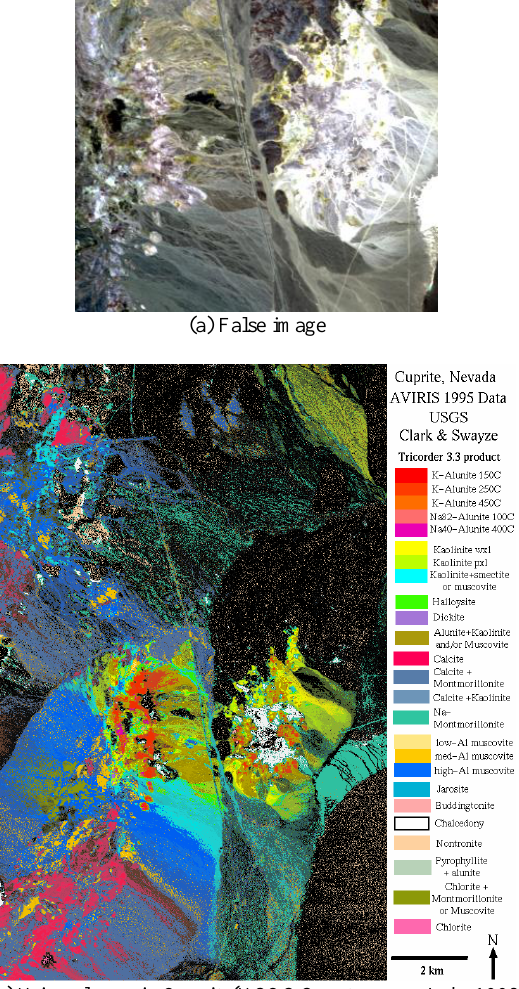
(b) Mineral map in Cuprite(USGS Spectroscopy Lab, 1998) Figure 1. An AVIRIS data set of